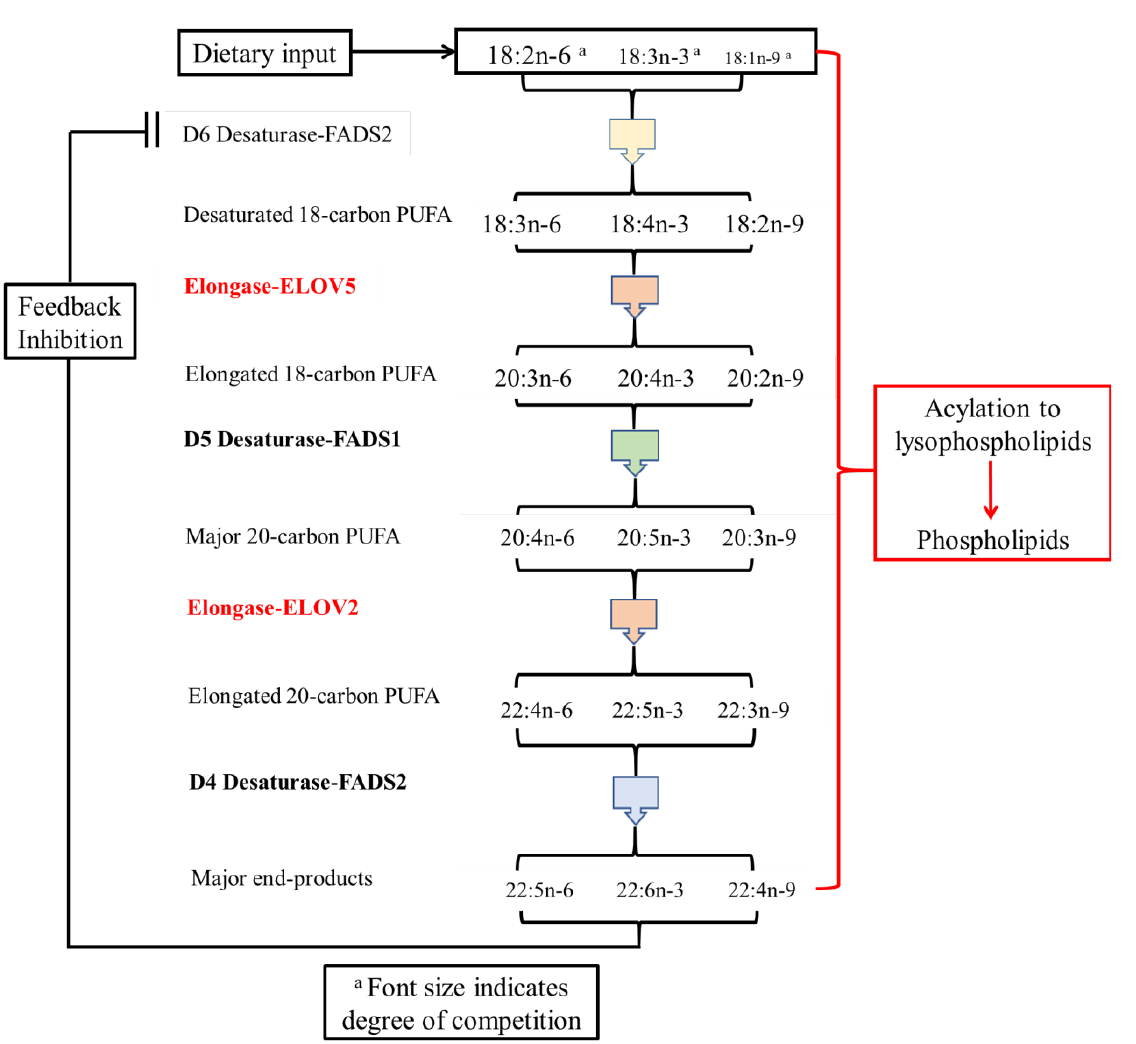
Figure A1. Metabolic pathway from 18-carbon polyunsaturated fatty acids to 22-carbon polyunsaturated fatty acids. LA (18:2n-6), ALA (18:3n-3) and oleic acid (18:1n-9) are substrates for the same